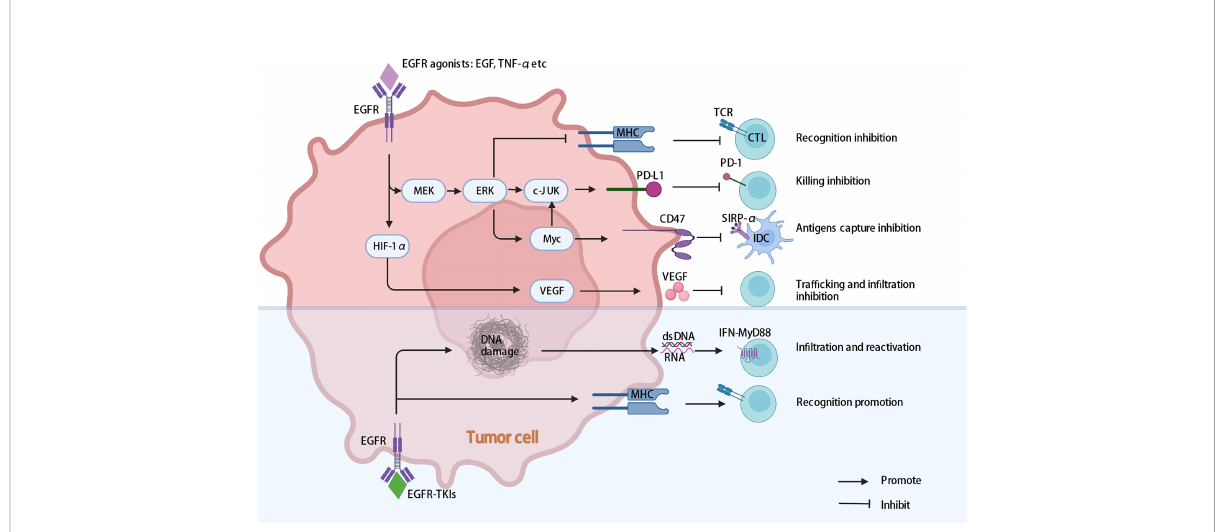
FIGURE 3 Multiple intrinsic cancer cell pathways induce cancer cell immune evasion in EGFR-mutant NSCLC. EGFR activating mutations may help cancer cells escape cytotoxic T-cell recognition and speci fi c killing by promoting PD-L1 expression and downregulating MHC expression. The activation of EGFR may in fl uence the expression of VEGF, inhibiting T lymphocyte in fi ltration into tumors, generating vascular endothelial growth and promoting tumor progression. In addition, activation of EGFR may in fl uence the expression of CD47, decreasing the phagocytosis of cancer cells by DCs. In addition, EGFR-TKIs enhance MHC expression, and HypoTKI can induce more dsDNA and RNA release and trigger MyD88 – type I IFN innate sensing pathways, which enhance tumor-speci fi c T-cell in fi ltration and reactivation. EGFR, epidermal growth factor receptor; MEK/ERK, extracellular signal-regulated kinase (ERK) kinase MEK; MHC, major histocompatibility complex; EGFR-TKIs, epidermal growth factor receptor tyrosine kinase inhibitors; HypoTKI, low-fractionated EGFR-TKIs; DCs, dendritic